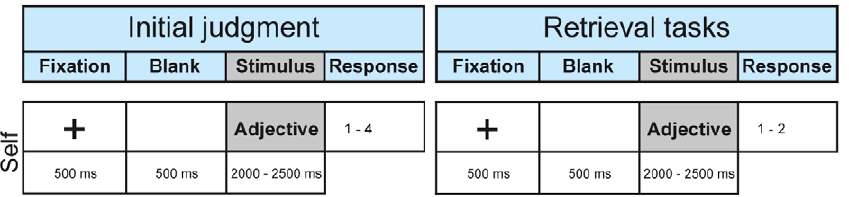
Figure 2. Time-lines of the experiments. Three different blocks of 40 different, randomly selected, common adjectives were used. Initially a personal judgment was recorded on a four-point scale of how well each adjective fitted him or herself. About 4 min after personal judgment of each adjective, the same adjectives were shown again in a different order for autobiographical memory retrieval. Retrieval response was made on a two- point scale (rather fitting or not fitting). Data collection for the present study was limited to the retrieval process. The order of the blocks was balanced to obtain an even distribution.